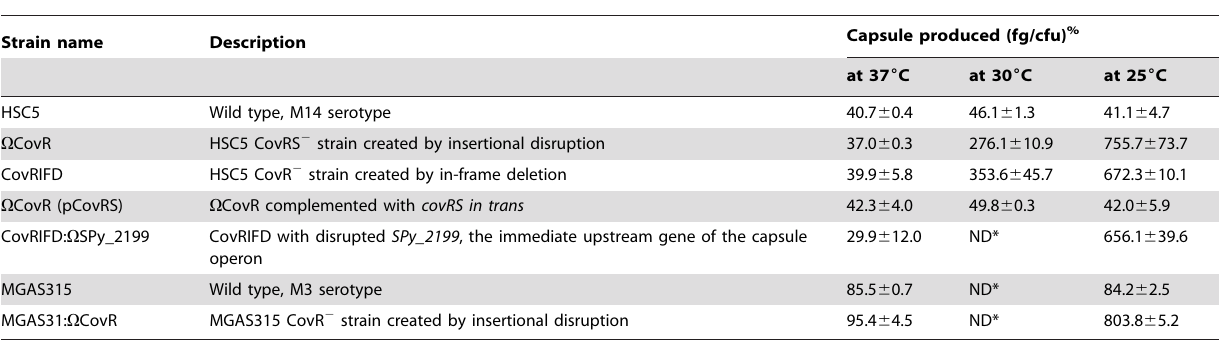
Table 2. The amount of capsule produced by S. pyogenes strains at different